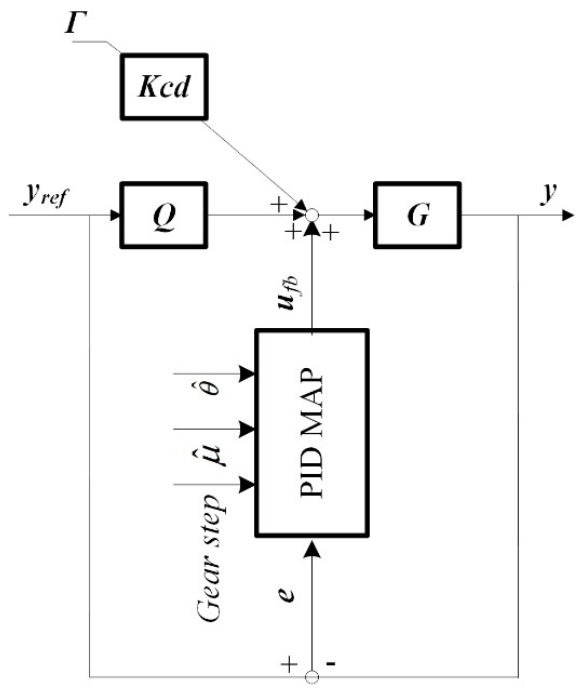
Figure 7. Flow diagram of the designed controllers.